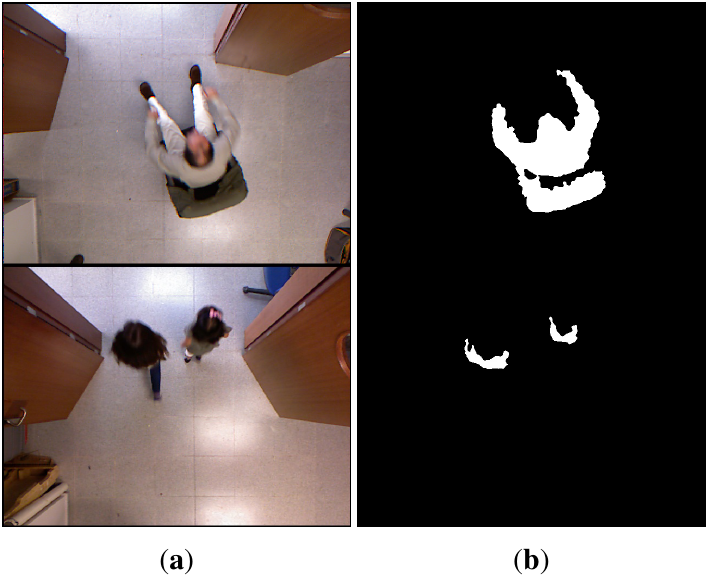
Figure 3. ( a ) RGB image; ( b ) corresponding foreground mask of short